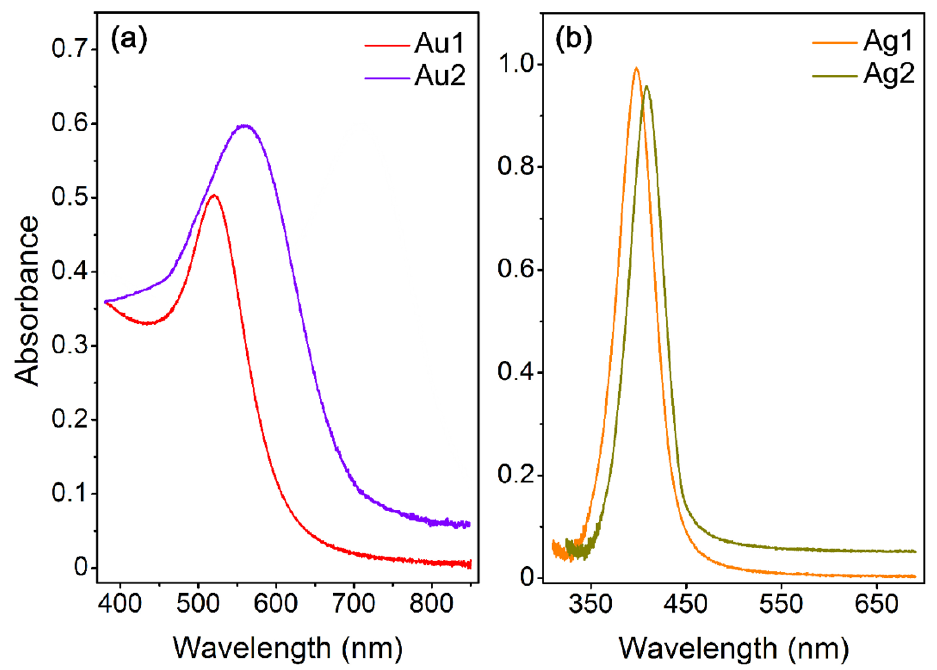
Figure 2. UV–Vis spectra of gold ( a ) and silver ( b ) colloids with average size of AuNPs and AgNPs of 12–15 nm (Au1, Ag1) and 22–25 nm (Au2, Ag2).